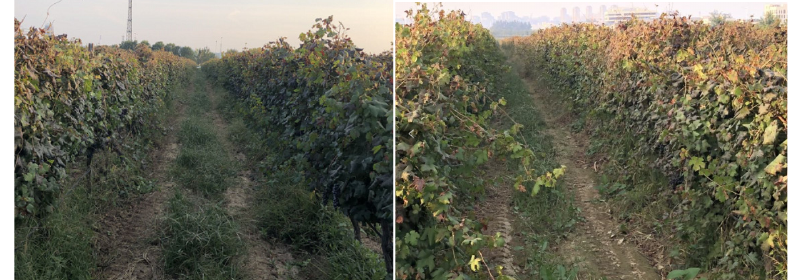
Figure 3. Tree trunks are blocked by tall